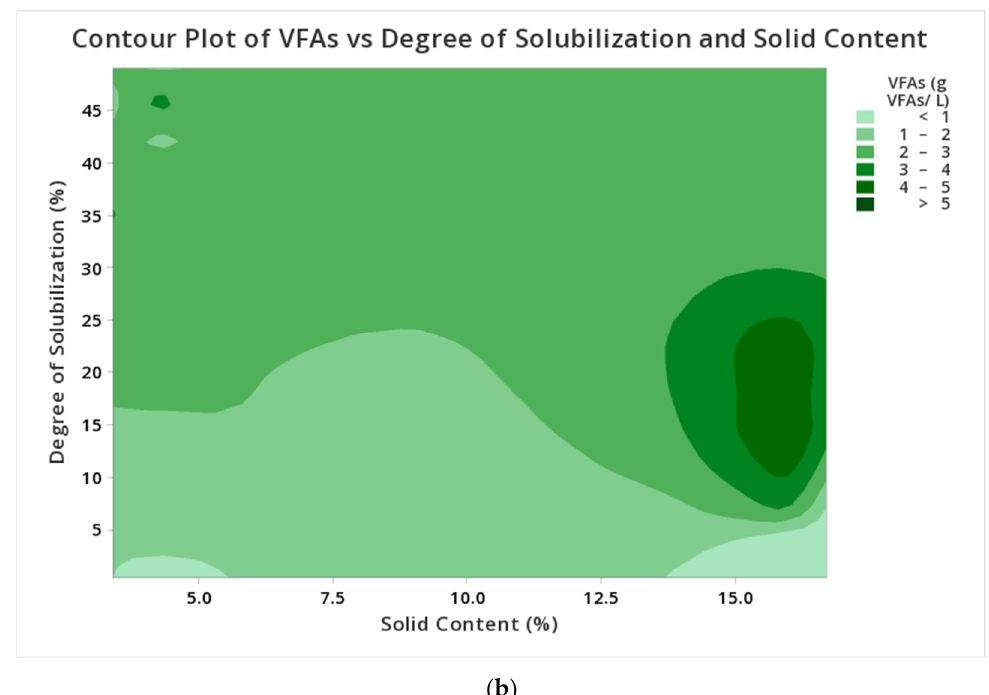
Figure 2. Contour plots for VFA production vs. solubilization and hydrothermal pretreatment parameters, ( a ) Contour plot of VFA vs. temperature and retention time, ( b ) Contour plot of VFA vs. COD solubilization due to HTP and solid content of sludge.